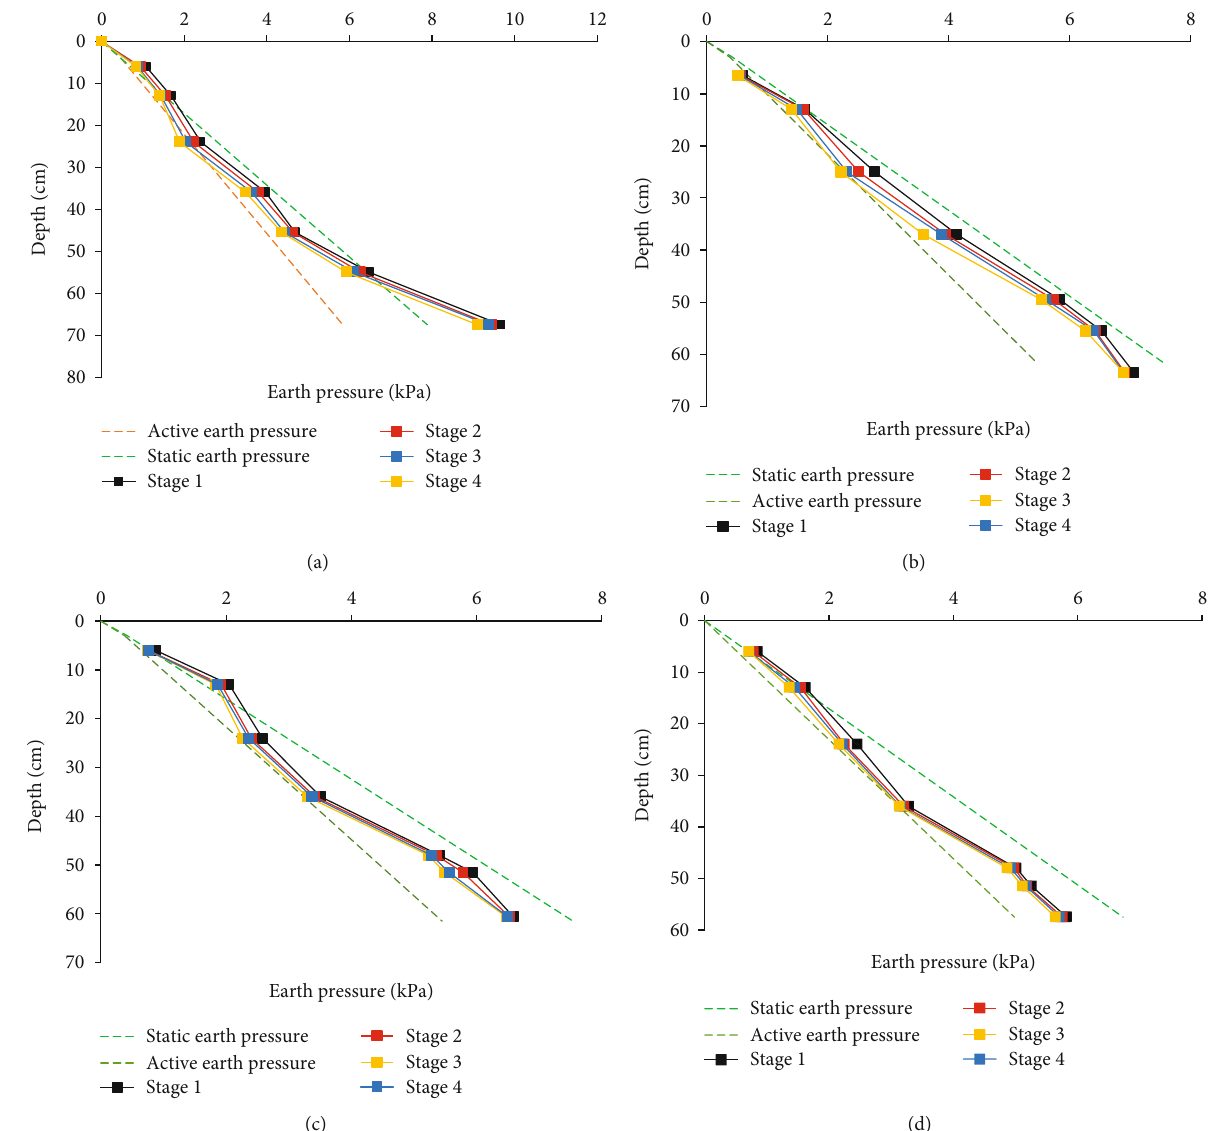
Figure 12: (a) Earth pressure behind the wall of 0.41H; (b) earth pressure behind the wall of 0.33 H; (c) earth pressure behind the wall of 0.37H; (d) earth pressure behind the wall of